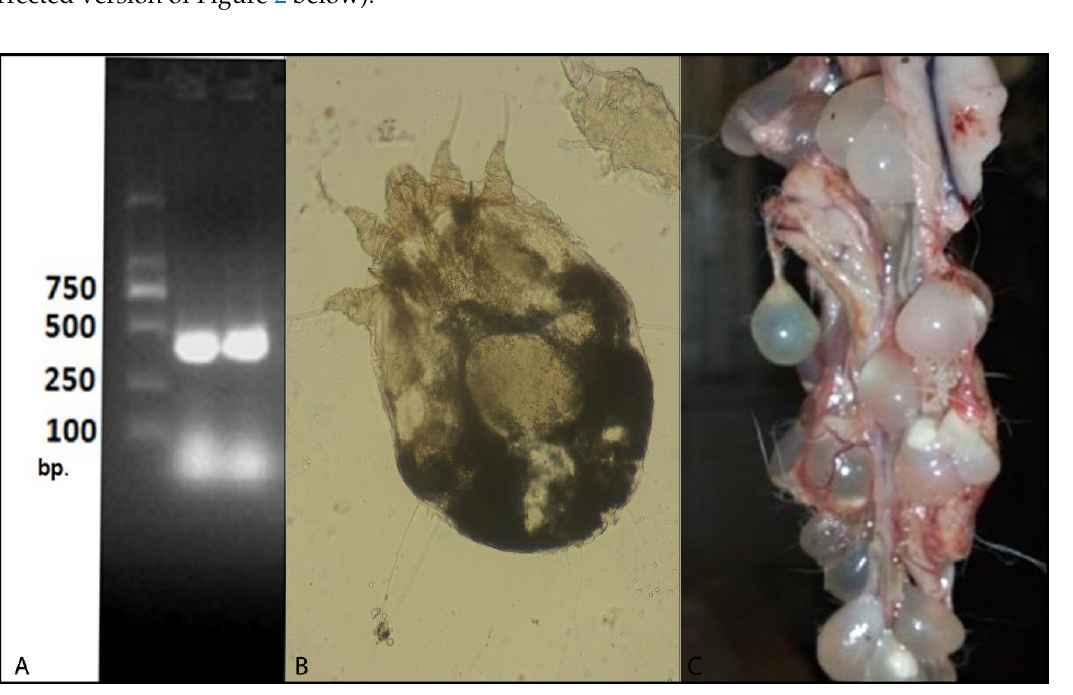
Figure 2. ( A ) Analysis of Salmonella pure culture with the primer set: ST11-ST15. Lane 1 and Lane 2: Salmonella ( B ) Sarcoptes scabiei from the rabbit skin, and ( C ) Cysticercus pisiformis from the peritoneal cavity of rabbits .